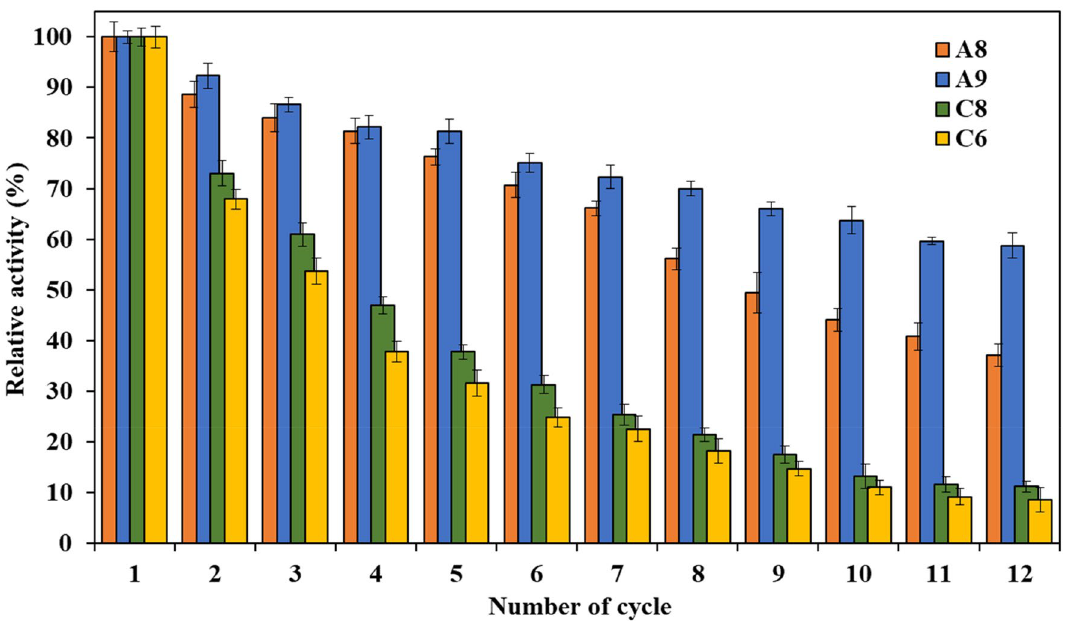
Figure 8. Reusability of the immobilized PersiXyn9 on the selected hydrogel